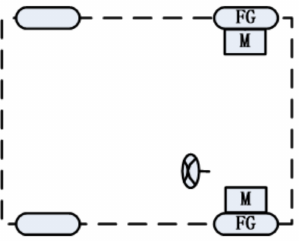
Figure 2. The motor distributed drive